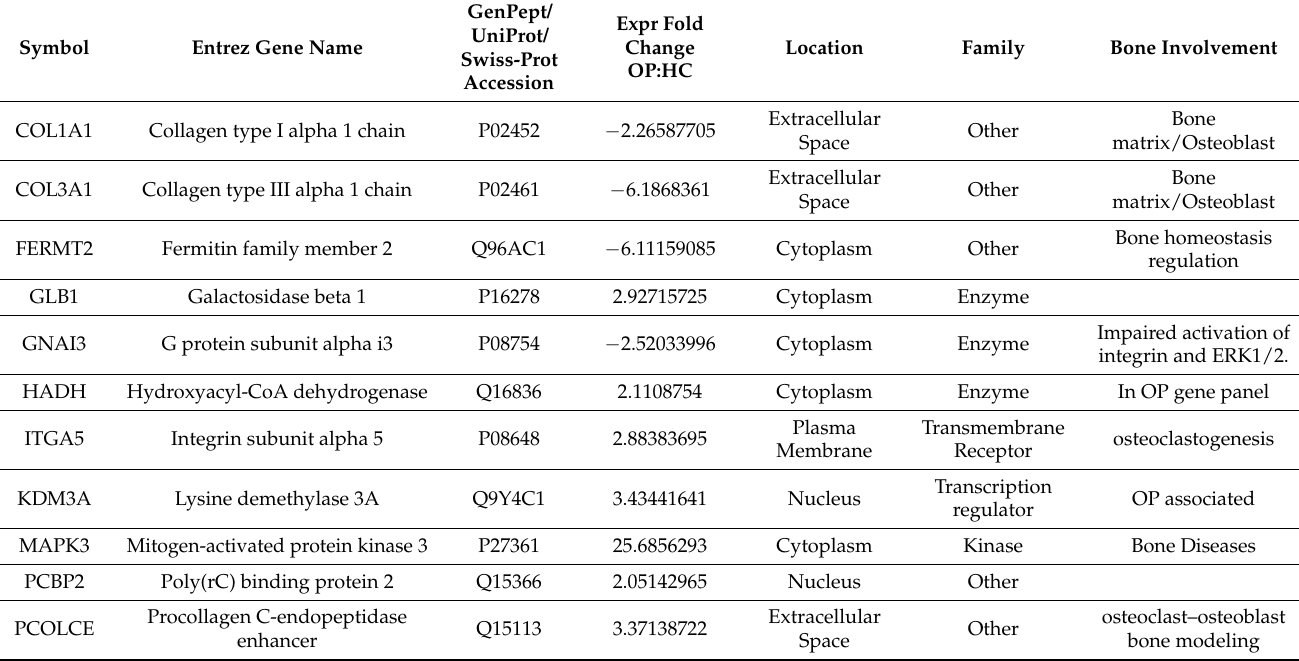
Table 2. Some of the 86 proteins in the dataset that were significantly differentially expressed between the bulk undifferenti- ated HC and OP samples were mapped in Ingenuity Pathway Analysis (IPA). Their functional annotations are indicated, as are their involvements in osteogenesis as well as in different bone and connective tissue